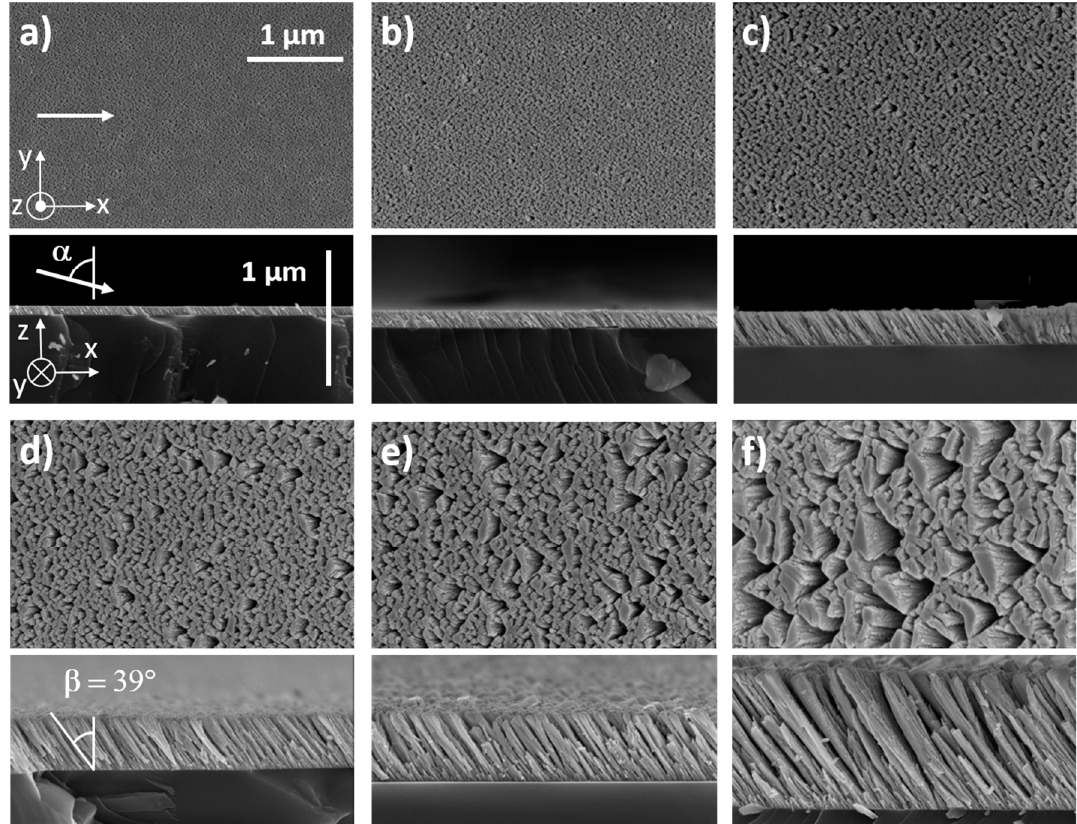
Figure 2. Top and cross-section views performed by SEM of W films sputter-deposited with a substrate angle α = 80° and an argon sputtering pressure P Ar = 4.0 × 10 − 3 mbar. White arrows indicate the direction of incoming particle flux. Column angle β was nearly constant (39° ± 2°) whatever the film’s thickness, which was systematically increased from: ( a ) 50; ( b ) 100; ( c ) 200; ( d ) 450; ( e ) 600, and ( f ) 1000 nm.